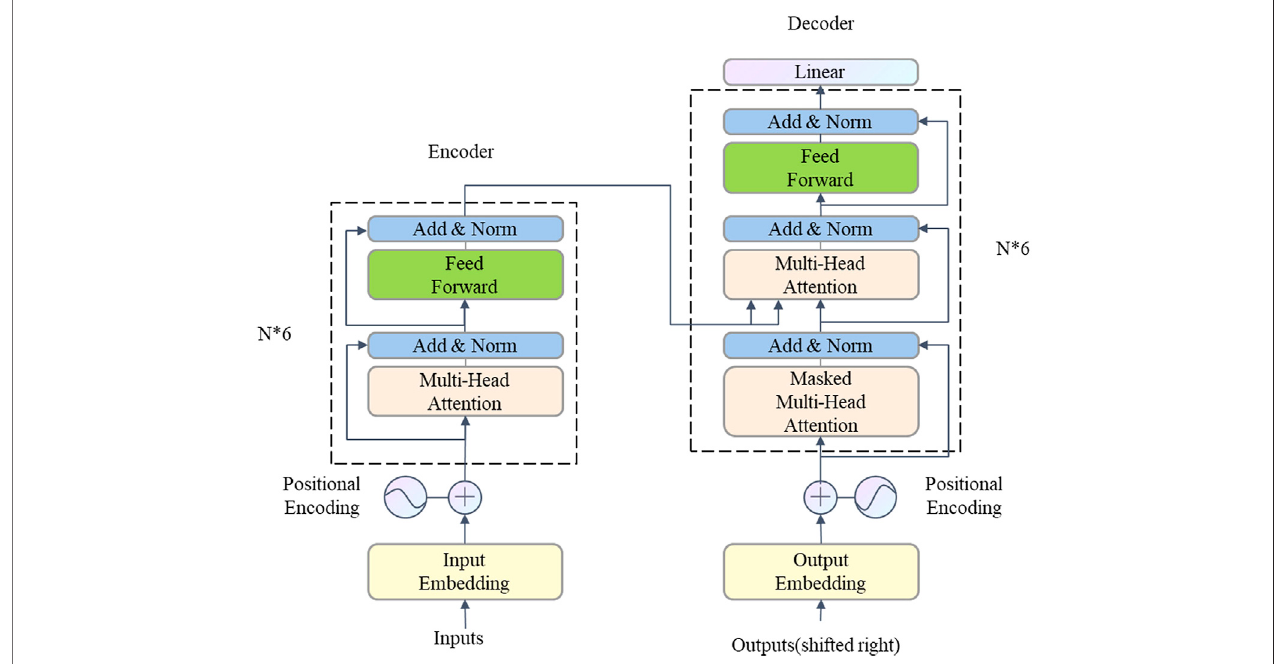
FIGURE 1 | The architecture of BERT.